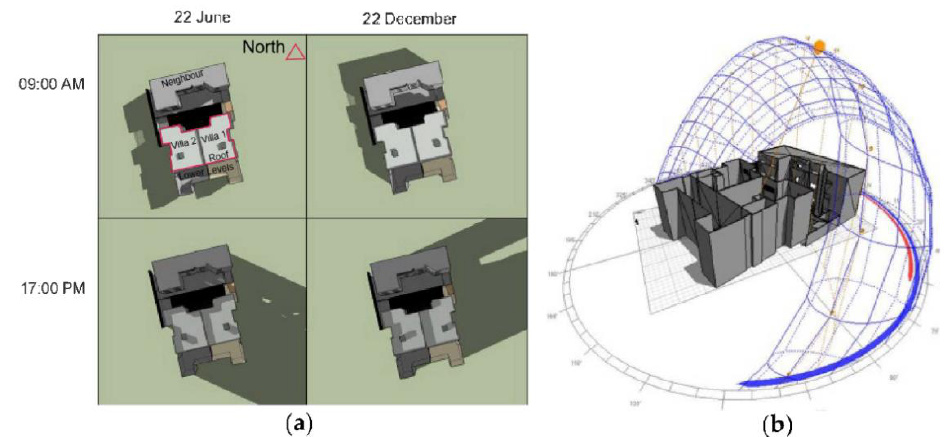
Figure 18. ( a ) Shading simulation for the two Villas at 09:00 and 17:00, during summer (left) and winter (right); ( b ) sunlight tracking using Autodesk Ecotect software.